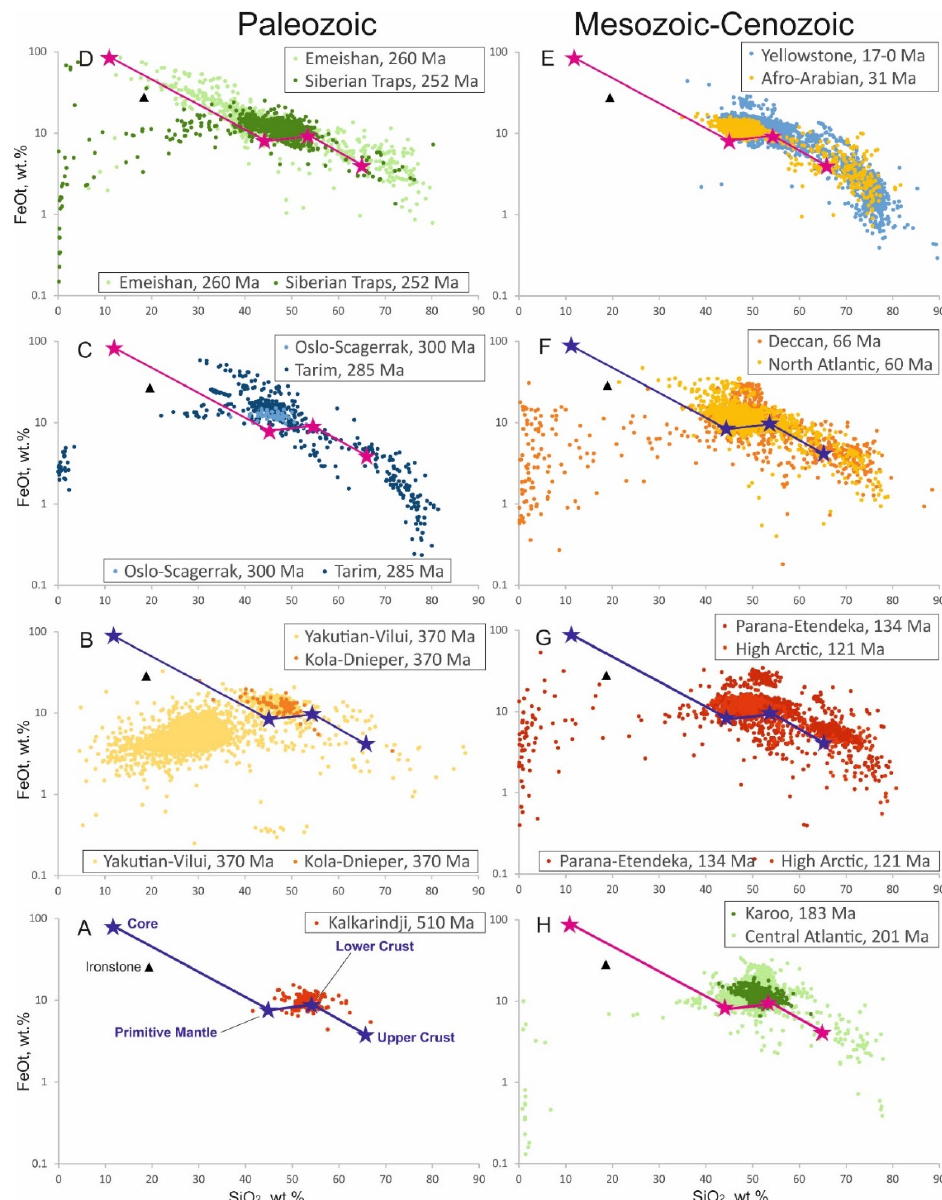
Figure 4. The SiO 2 /FeOt ratio in magmatic rocks of the selected LIPs. FeOt is total iron as FeO. Compositions of ironstone deposits, the core, primitive mantle, and crust are shown after [22,24–26], respectively. Data sources are cited in Section 2. ( A ) Kalkarindji; ( B ) Yakutian-Vilui and Kola-Dnieper; ( C ) Scagerrak and Tarim; ( D ) Emeishan and Siberian Trips; ( E ) Yellowstone and Afro-Arabian; ( F ) Geccan and North Atlantic; ( G ) Parana-Etendeka and High Arctic; ( H ) Karoo and Central